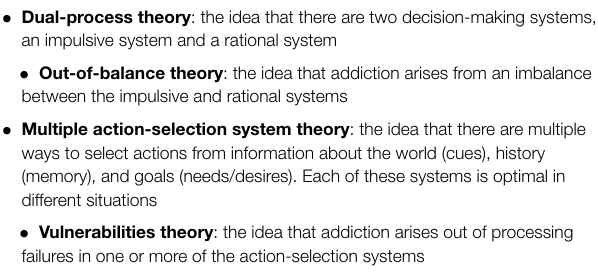
TABLE 2 | Economic theoretical constructs used in this article